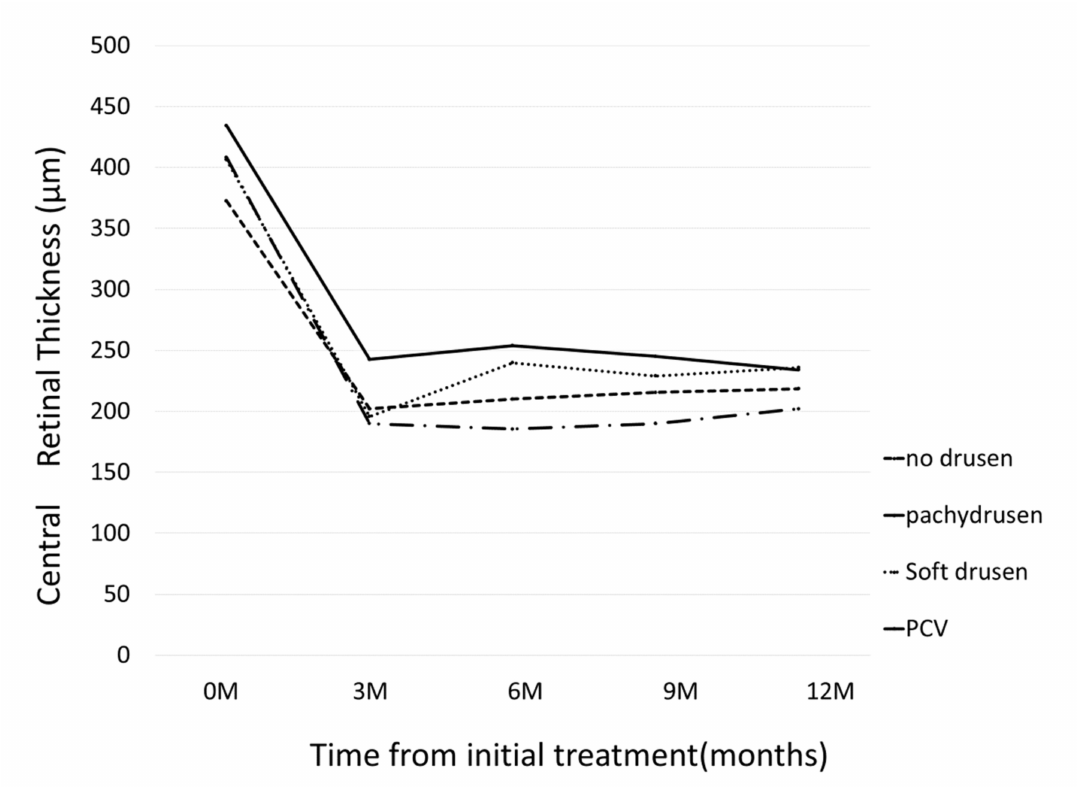
Figure 4. Changes of central retinal thickness (CRT) from initial treatment according to the groups. In pachydrusen group, CRT significantly decreased from 408 ± 171 (baseline) to 190 ± 98, 185 ± 82, 190 ± 86, 202 ± 113 at 3 months, 6 months, 9 months, and 12 months, respectively. (all p -value < 0.001) In no drusen group, CRT significantly decreased from 373 ± 160 (baseline) to 202 ± 81, 210 ± 71, 215 ± 75, 218 ± 85 at 3 months, 6 months, 9 months, and 12 months, respectively. (all p -value < 0.001) In soft drusen group, CRT significantly decreased from 406 ± 210 (baseline) to 196 ± 69, 240 ± 113, 229 ± 114, 236 ± 122 at 3 months, 6 months, 9 months, and 12 months, respectively. (all p -value < 0.001) In PCV / Scarring group, CRT significantly decreased from 434 ± 132 (baseline) to 242 ± 99, 254 ± 114, 245.0 ± 84, 234 ± 83 at 3 months, 6 months, 9 months, and 12 months, respectively. (all p -value <